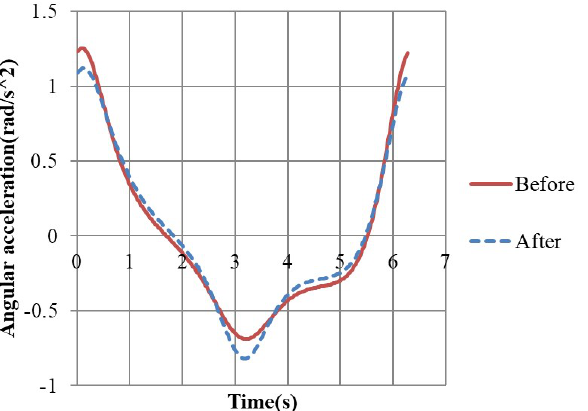
Figure 14. The angular acceleration α 4 of the driver side output-link of CDLS before/after DE optimization.